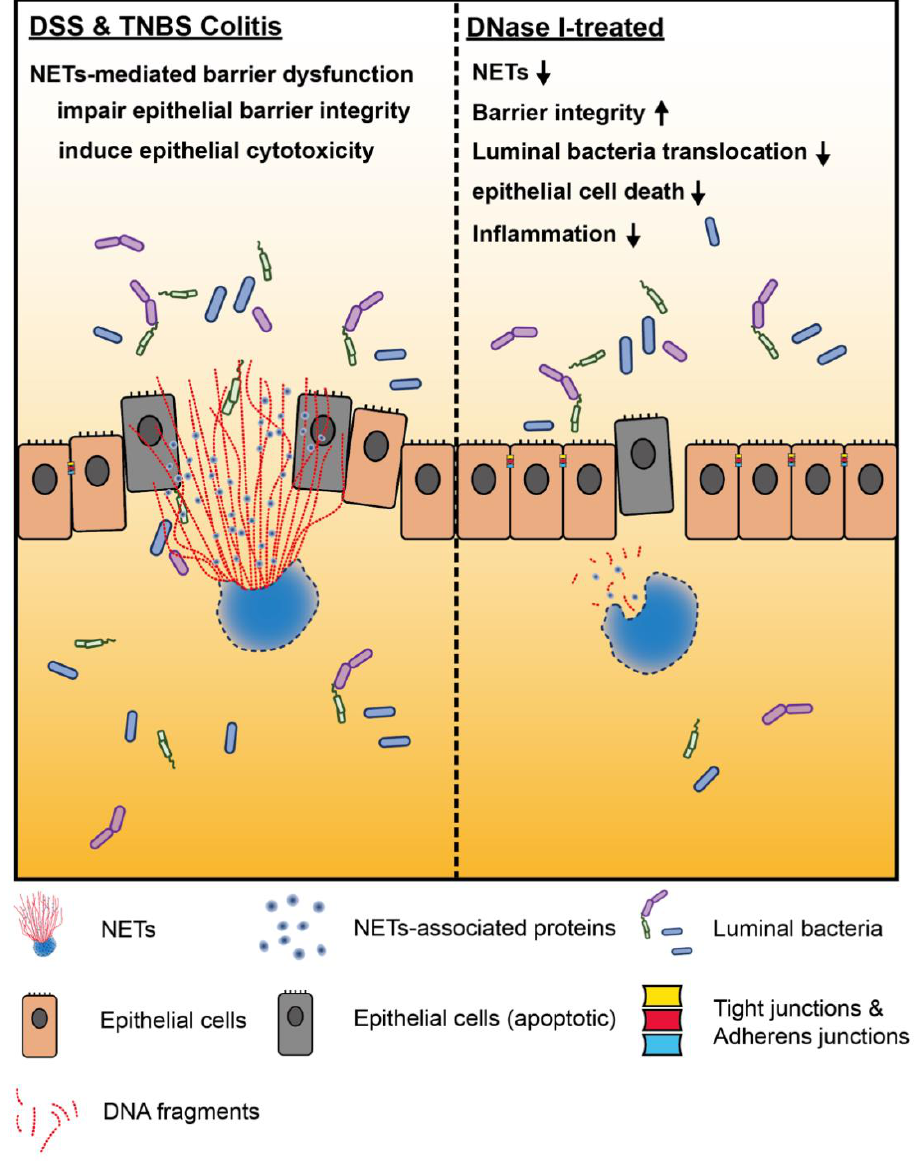
Figure 7. Neutrophil extracellular traps (NETs) exacerbate mouse experimental colitis by impairing intestinal barrier function. (Left) NETs are abundant in the colon of mouse in DSS-induced or TNBS-induced colitis models. In the colon of non-treated mouse, aberrant NET formation promotes the apoptosis of intestinal cells during colitis. NETs also alter intestinal epithelial permeability leading to luminal bacterial translocation into the colon and MLN as well as gut inflammation in vivo. Mechanistically, histones are the major protein components of NET structure that decrease the intestinal barrier integrity and function, as well as promotes the cytotoxicity of intestinal epithelial cells. (Right) Disruption of NET structure with DNase I in mice with DSS-induced or TNBS-induced colitis protects the host from intestinal inflammation and injury by restoring the intestinal barrier integrity and function that prevent luminal bacterial translocation into the colon and MLN, suggesting that NETs play a distinct role that is required for the development and pathogenesis of colitis.